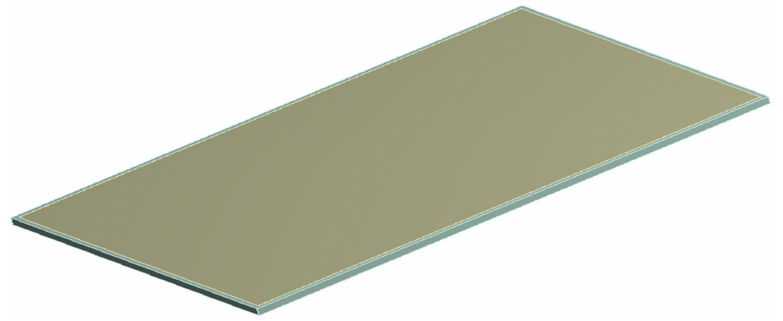
Figure 3. Solid model of the photovoltaic